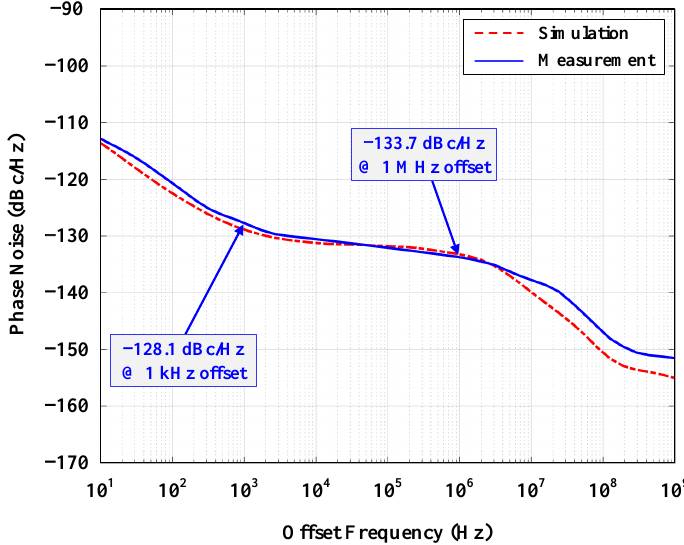
Figure 16. Measured 6.89 MHz oscillator phase noise compared to simulation.